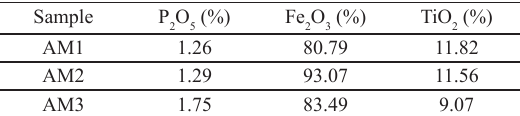
Figure 1. X-ray diffractogram of the magnetic tailings obtained from phosphate-rock processing in Alto Paranaíba. Table 1. XRF semi-quantitative results of the magnetic